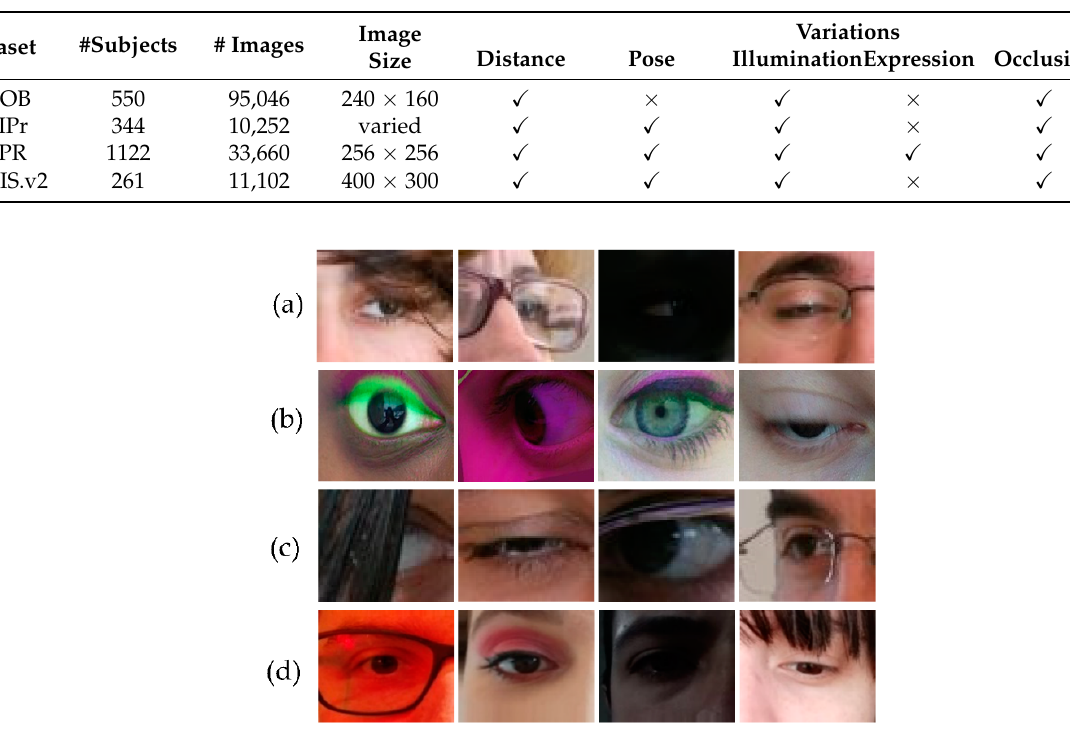
Table 2. Description of the collected benchmark databases.